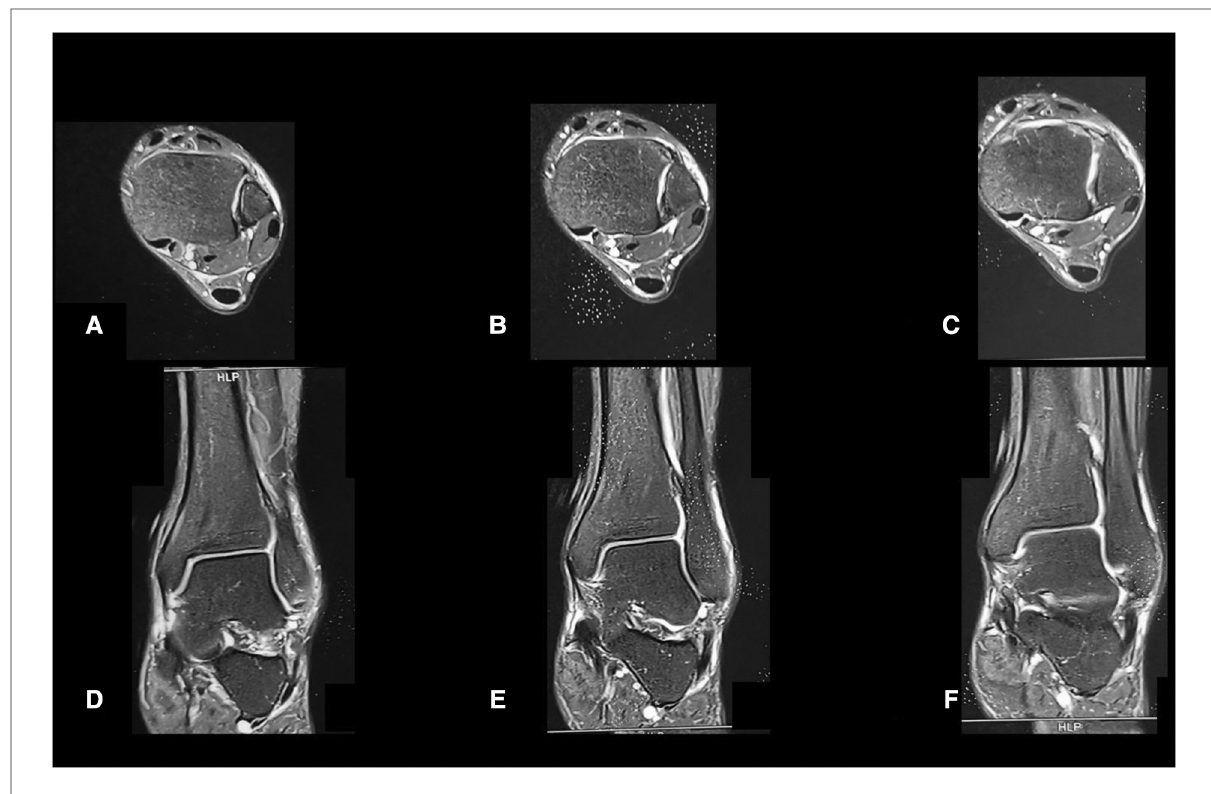
FIGURE 3 The initial transverse view ( A – C ) and coronal view ( D – F ) MRI images of the ankle.